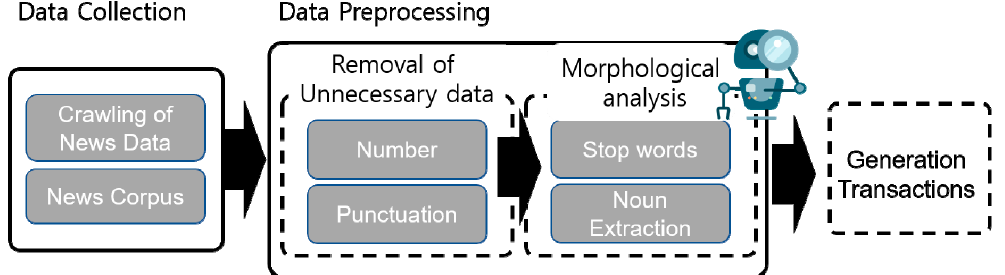
Figure 5. Preprocessing of News Corpus.